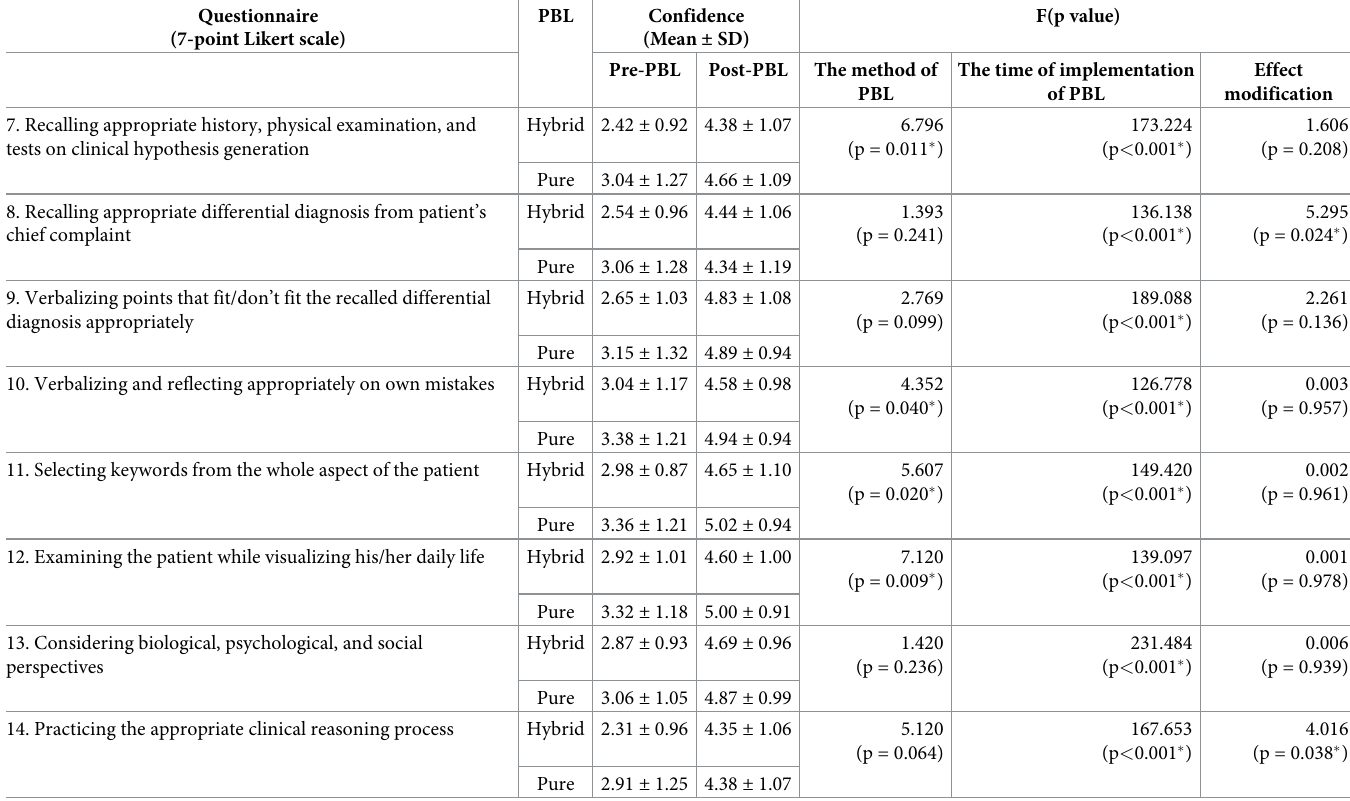
Table 6. A two-way ANOVA in fifth-year medical students’ self-evaluation of competency in clinical reasoning before and after the educational intervention based on the 7-point Likert scale, about hybrid- and pure-PBL, Chiba University Hospital (N = 99). Questionnaire (7-point Likert